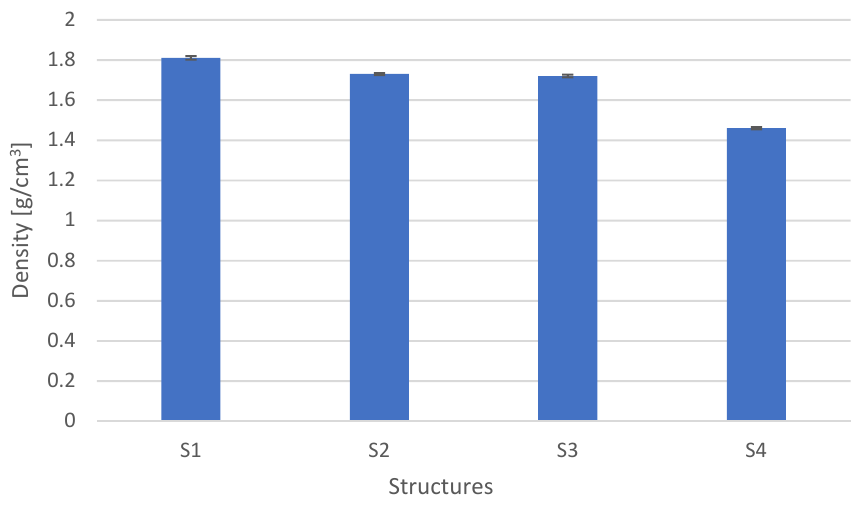
Figure 5. Density for different composite structures.